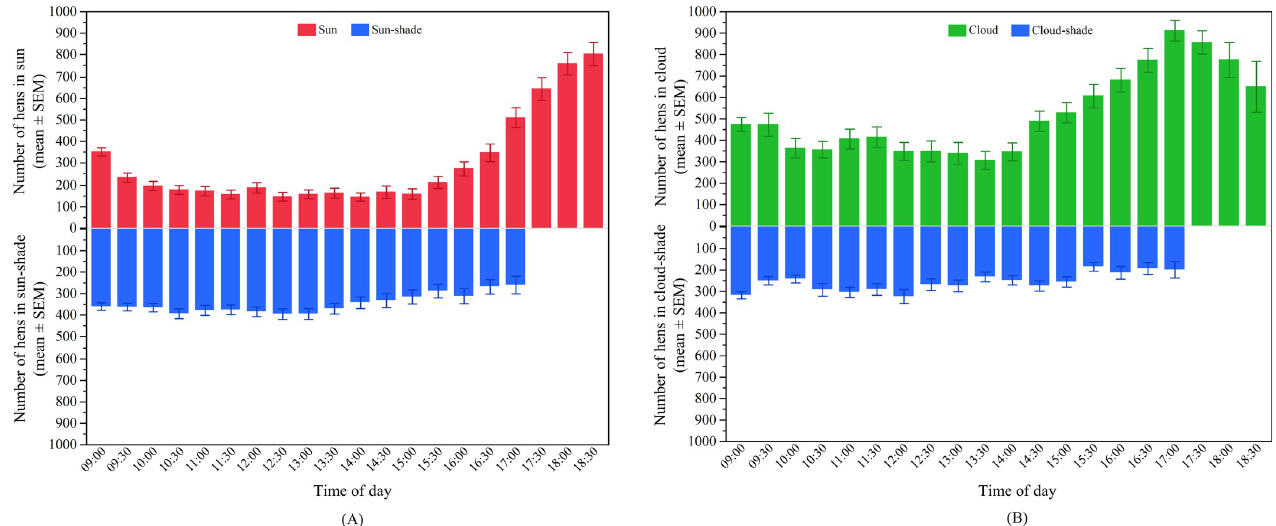
Fig 5. Distribution of hens on the range across the day in QLD: (A) The mean ( ± SEM) number of hens in the ‘sun’ (top) and ‘sun-shade’ (bottom); (B) The mean ( ± SEM) number of hens in the ‘cloud’ (top) and ‘cloud-shade’ (bottom).